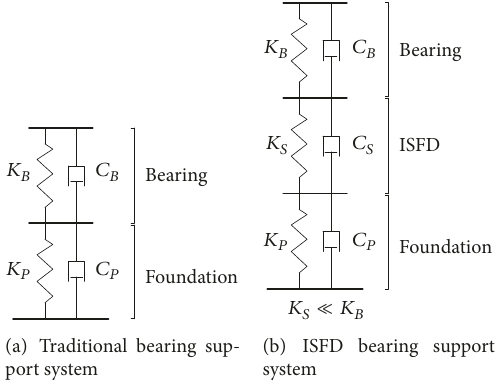
Figure 5: Mechanical models of traditional bearing support system and ISFD bearing support